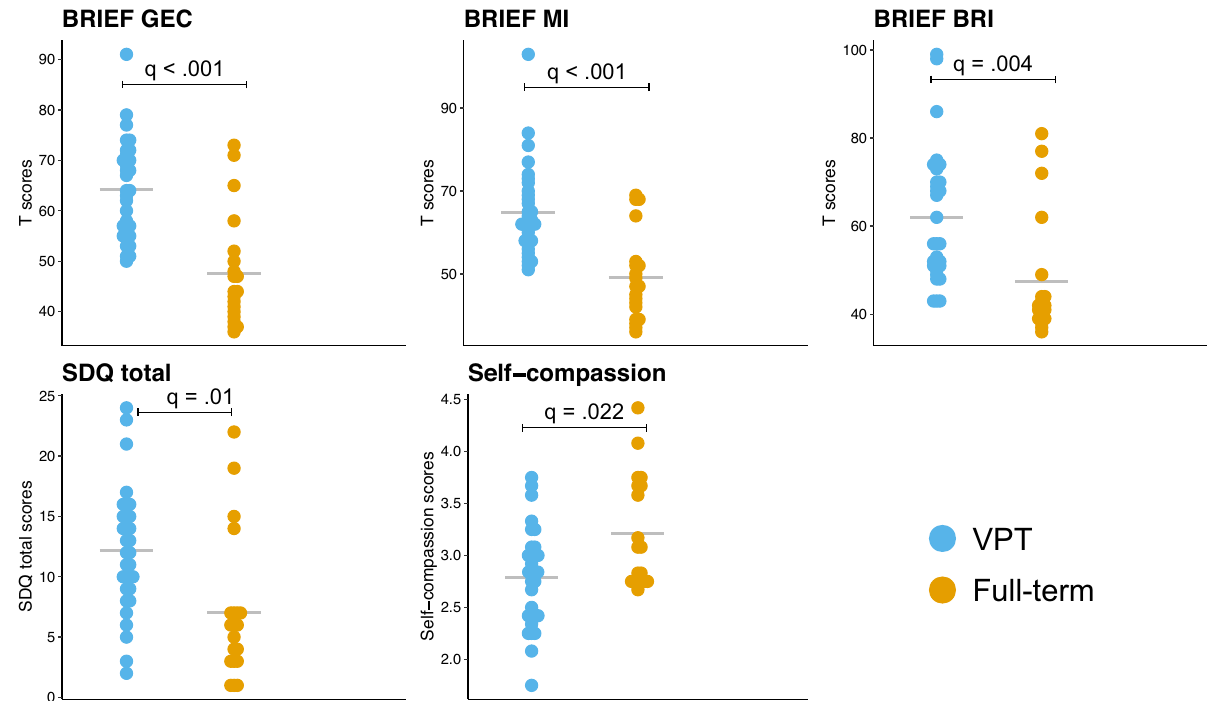
Figure 4. Neurobehavioural scores showing significant group differences between the VPT (prior to the MBI) and the full-term groups using independent sample t-test (FDR, q values < 0.05). The mean for each measure and each group is represented by a grey